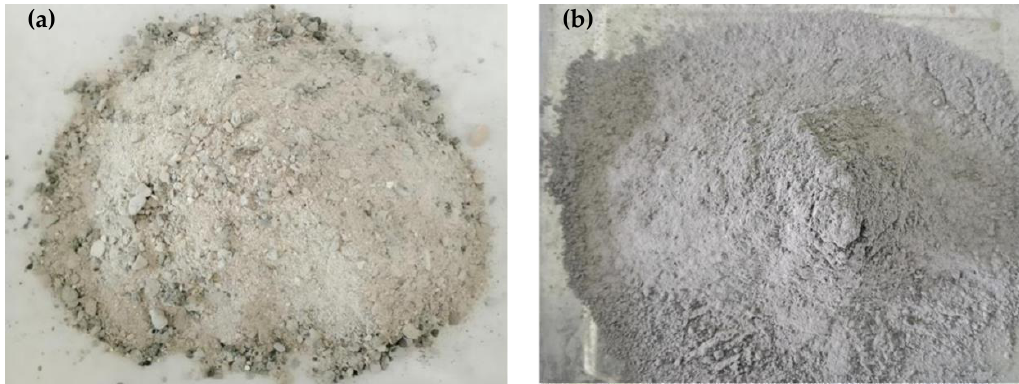
Figure 1. Digital images ( a ) Raw CFB-BA ( b ) Ground CFB-BA.